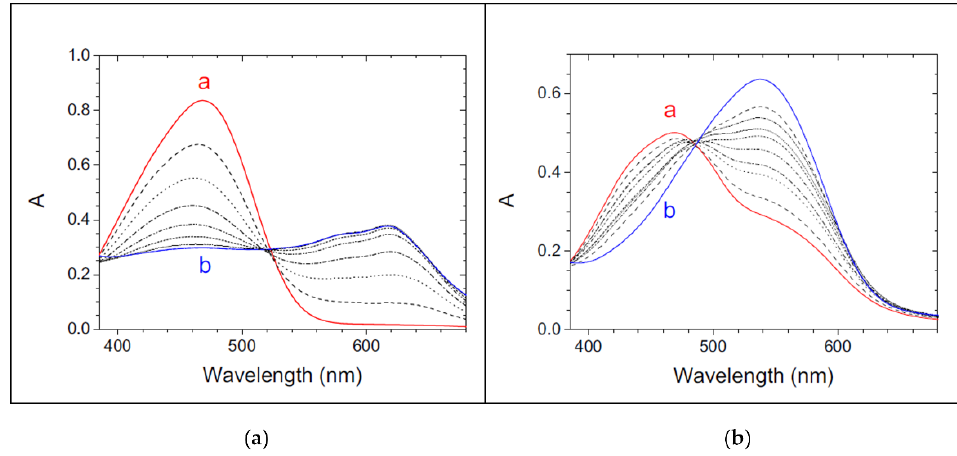
Figure 5. Spectral changes recorded during titration of PADA with Au 3+ ; C Au from 0 M (a, red line) to 1.0 × 10 − 3 M (b, blue line), C PADA = 3.0 × 10 − 5 M, C NaCl = 0.03 M, T = 25 ◦ C. ( a ) Water, pH 7.9 (0.03 M phosphate buffer), ( b ) SDS 0.02 M, pH 7.9. Figure adapted with permission from reference [80]. Copyright 2016 Else- vier.